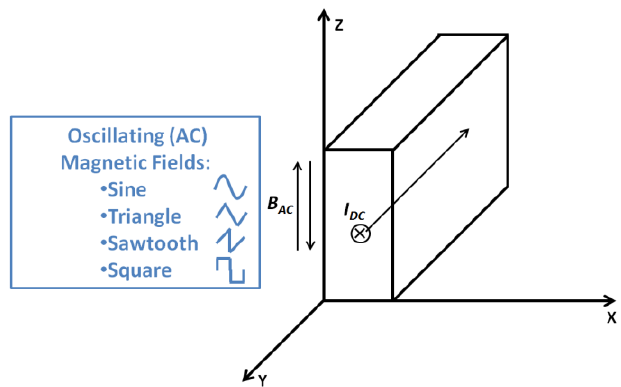
Figure 1. Bean model for a superconducting slab in the presence of an AC magnetic field in the z direction with infinite length in the y-z plane, with the add-ups of a DC transport current in the y direction and four different oscillating magnetic fields (sine, triangle, sawtooth and square).